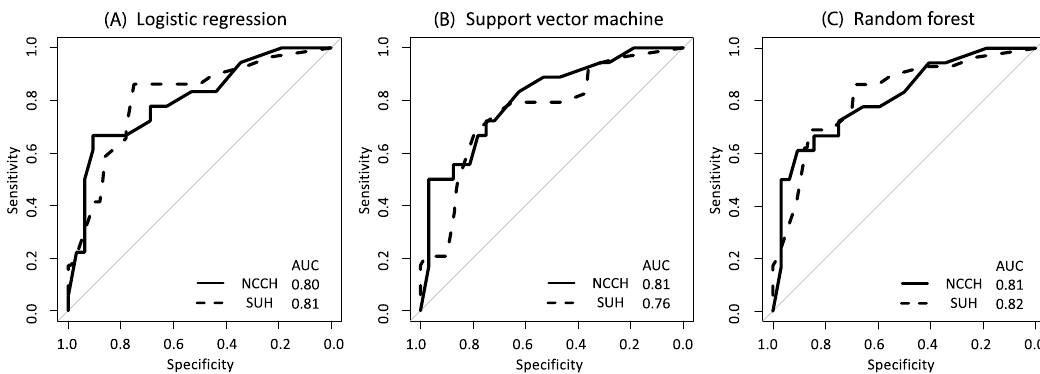
Figure 1. Performance of the preoperative predictive model for lymph node metastasis in endometrial cancer (training set: National Cancer Center Hospital training set ( n = 75), test set: NCCH test set ( n = 50), and Showa University Hospital set (n = 129). ( A ) Receiver operating characteristic (ROC) curves using logistic regression. ( B ) ROC curves using support vector machine. ( C ) ROC curves using random forest. The solid and dashed lines show the NCCH and the SUH test sets, respectively. AUC The area under the ROC curve, NCCH National Cancer Center Hospital, SUH Showa University